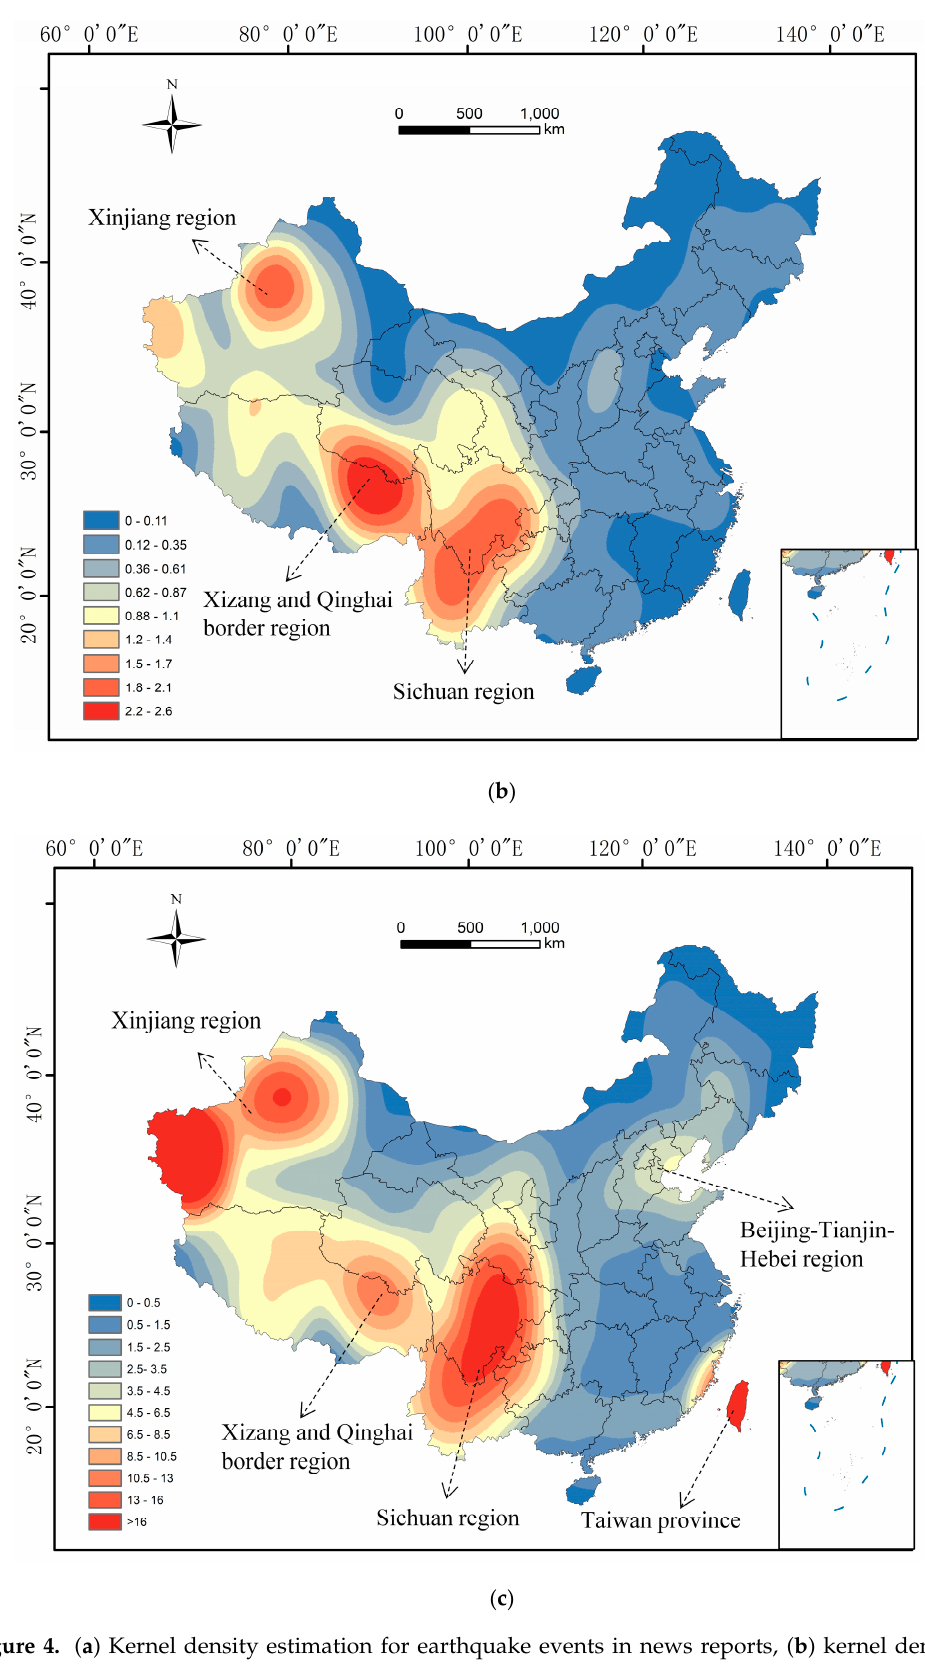
Figure 4. ( a ) Kernel density estimation for earthquake events in news reports, ( b ) kernel density estimation for earthquake events in professional reports, ( c ) kernel density estimation for earthquakes obtained from China Earthquake Networks Centre (CENC).